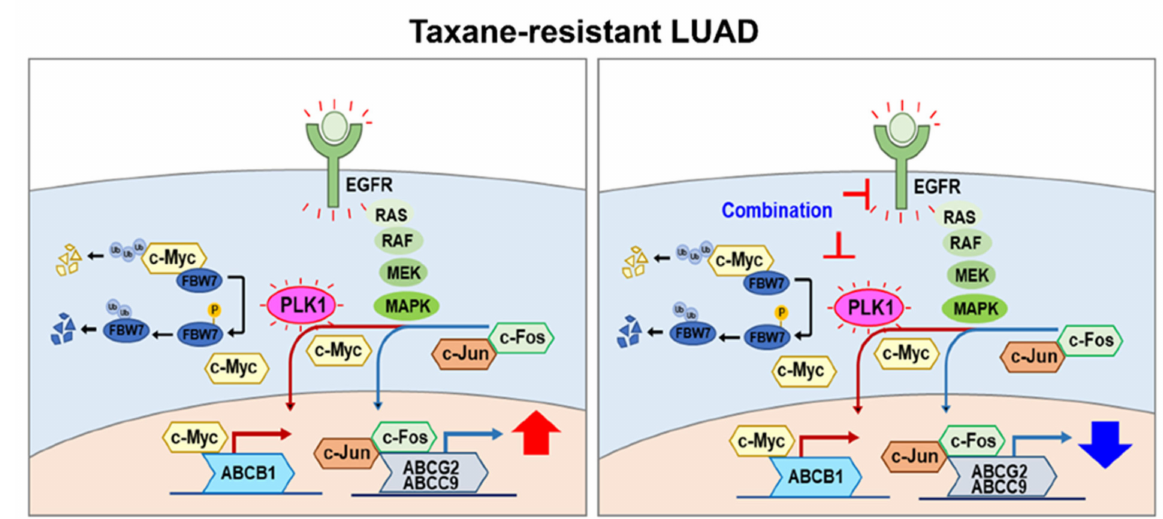
Figure 8. Plausible model of a combination effect using gefitinib and PLK1 inhibitor in taxane-resistant LUAD